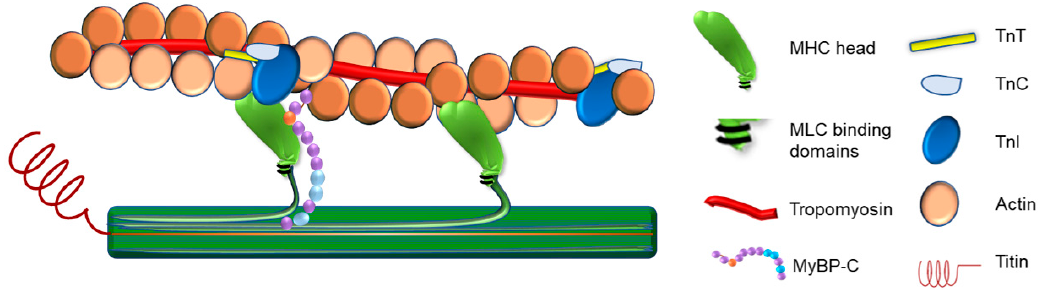
Figure 1. Illustration of the Cardiac Muscle Sarcomere. In this figure, the illustration shows the pro- teins assembled to construct the cardiac muscle